Question: Author a descriptive caption for the visualization shown.
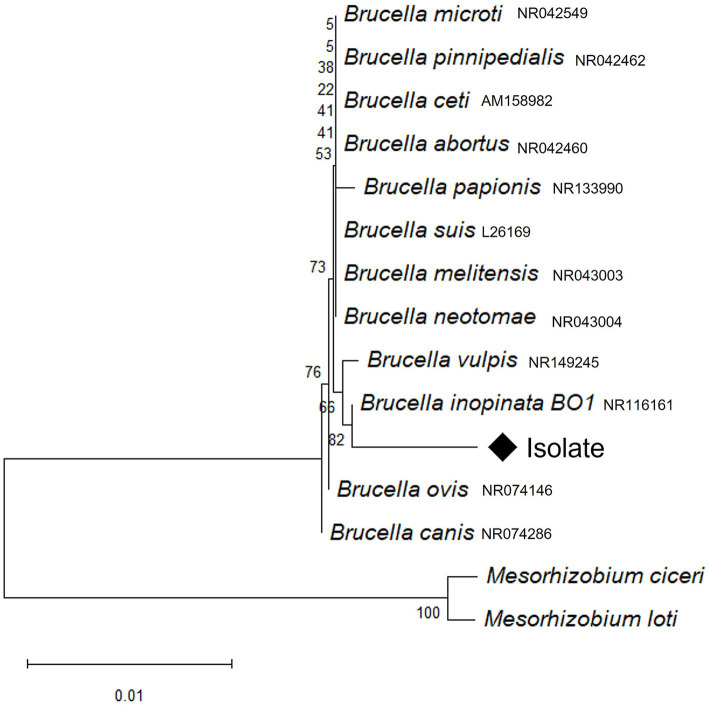
Answer: Neighbor-joining phylogenetic analysis based on 16S ribosomal RNA gene sequences in the GenBank database. A black diamond (◆) indicates the Brucella sp. identified in the waxy monkey treefrog ( Phyllomedusa bicolor ) in this study. Sequence alignments were performed using ClustalX version 1.8 ( 34 ); MEGA-X version10.1 ( 35 ) was used for phylogenetic analyses. Bootstrap percentage values are shown on the branches.